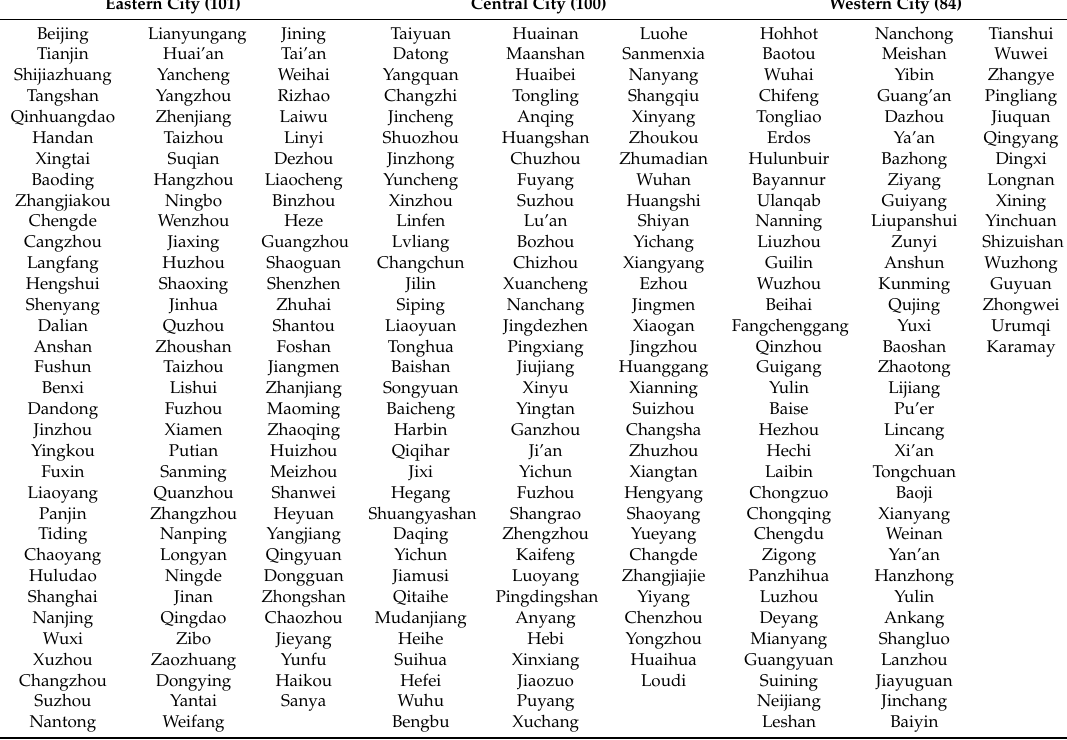
Table A1. The 285 prefecture-level